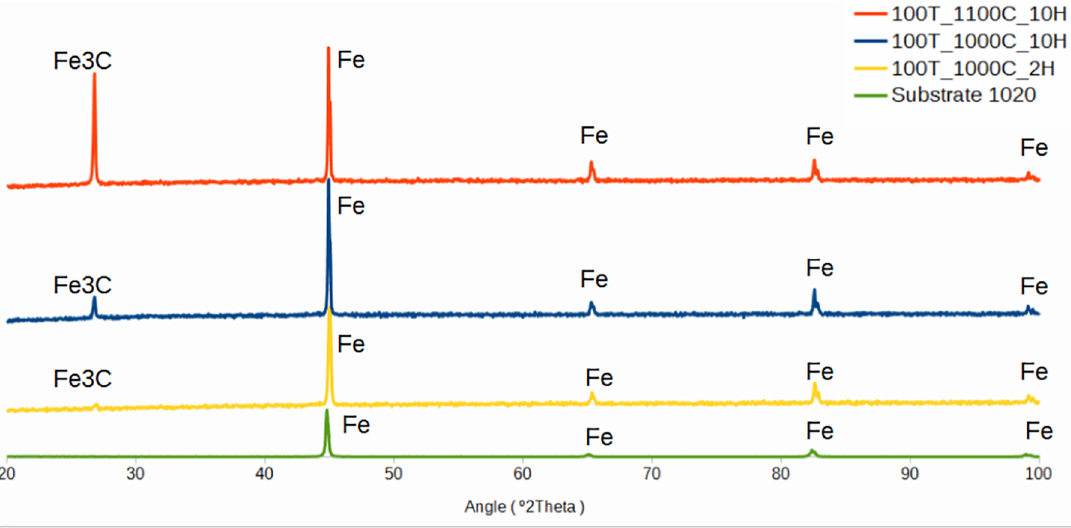
Fig. 9a represents X-ray diffraction of the reference Fe B peaks are observed after a progressive removal 2 AISI 1020 steel surface without treatment. X-ray diffraction material. The same peaks, in Fig.9c, are detected in layers at 150 µm and 250 µm below the surface. After 500 µm of the borided surface (Fig. 9d) shows peaks of Fe B (01- 2 material removal, X-ray diffraction analysis is similar to 072-1301), FeSi (01-088-1298) and Fe Si (00-035-0519). 3 the pattern of AISI 1020 steel surface without treatment Similar results were found by Carbucicchio et al . 43 , when showing only Fe replacing SiC by SiN in the powder mixture. FeB and 4